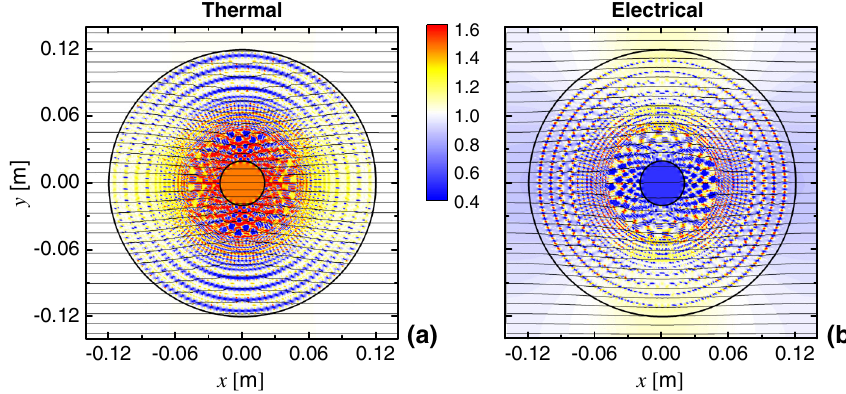
FIG. 5. (a),(b) As in Figs. 4(e) and 4(f), respectively, but assuming the realistic material parameters in Table II.